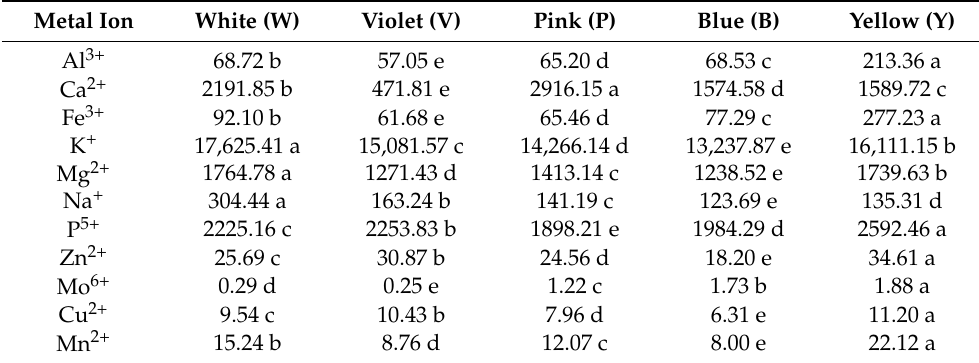
Table 3. Comparison of metal ion concentrations (mg/kg) in five Bletilla color varieties: White (W), Violet (V), Pink (P), Blue (B), and Yellow (Y). Metal Ion White (W) Violet (V) Pink (P) Blue (B) Yellow (Y) Al 3+ 68.72